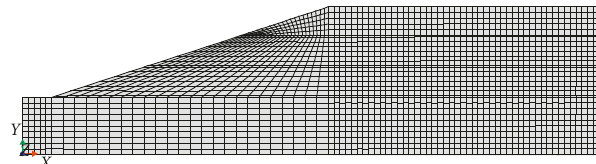
Figure 7: Mesh of the finite element